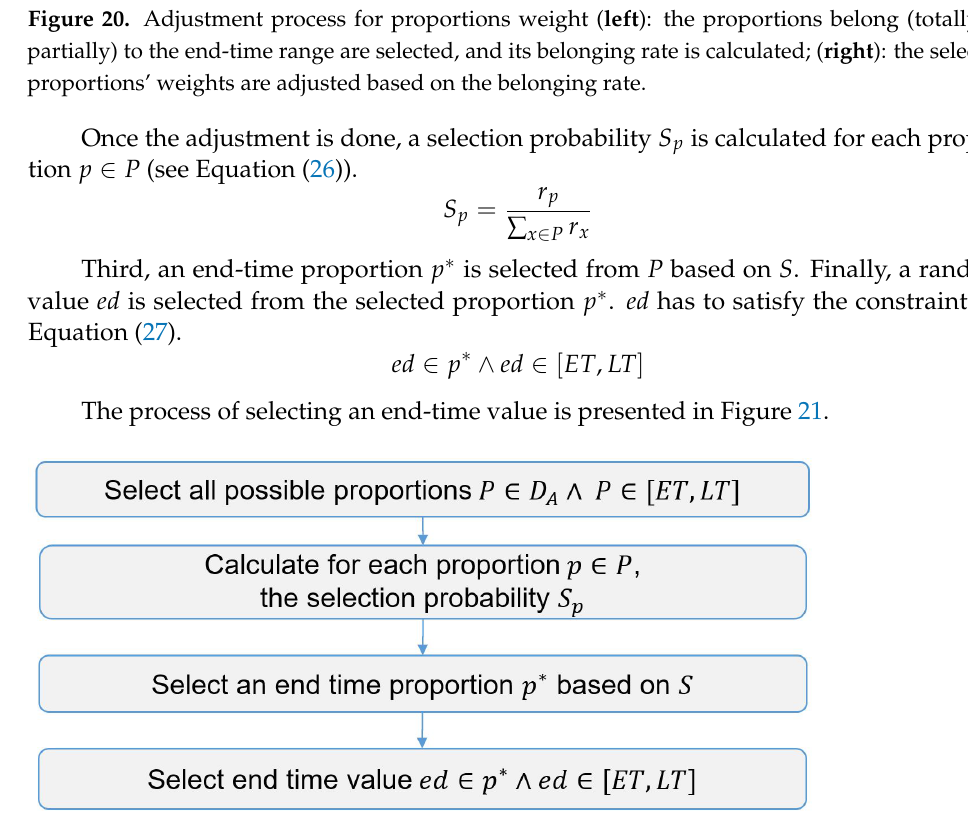
Figure 21. Select end-time value